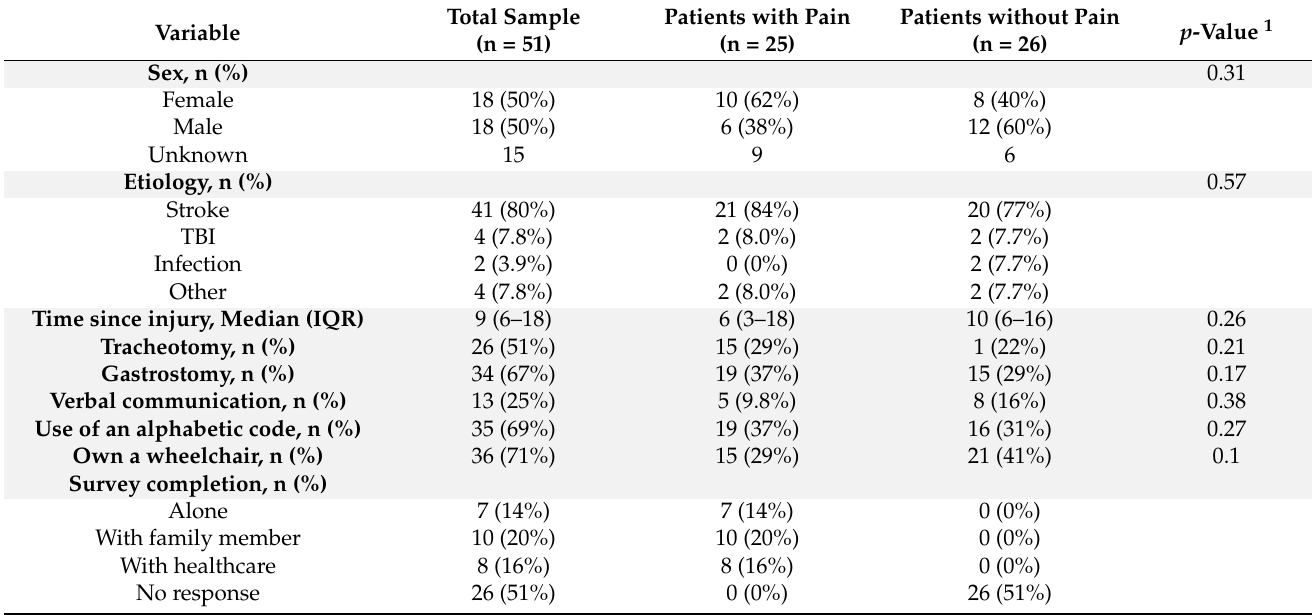
Table 1. Summary of the socio-demographic information and clinical status for the whole sample and for the group of patients with and without